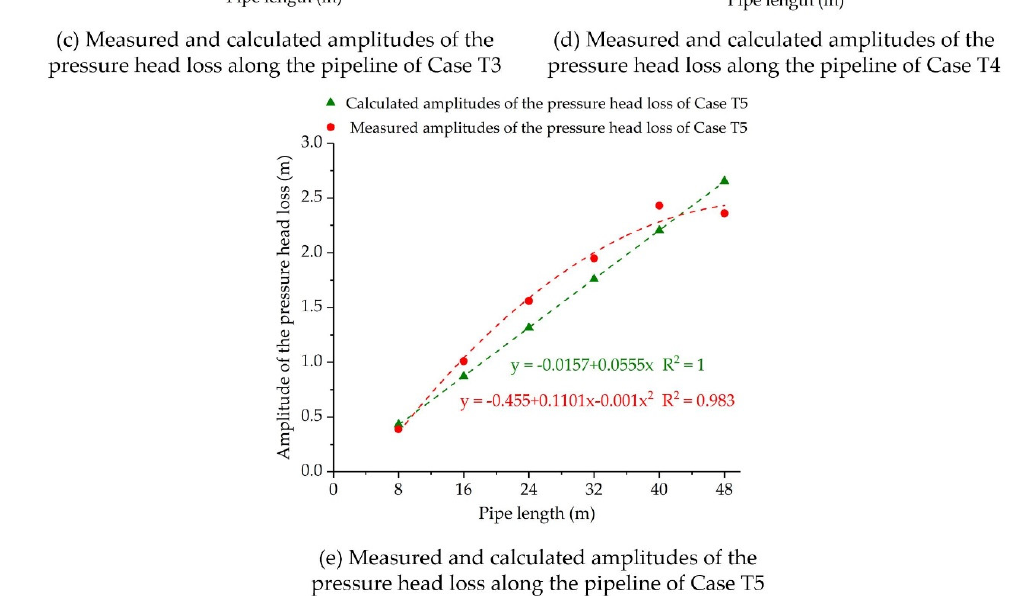
Figure 7. Comparisons of measured and calculated amplitudes of the pressure head loss along the pipe for ( a ) Case T1, ( b ) Case T2, ( c ) Case T3, ( d ) Case T4, and ( e ) Case T5.